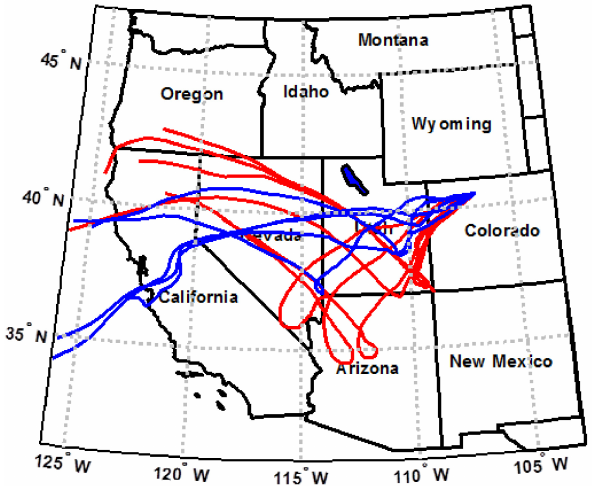
Fig. 5. Back trajectories for 11 March (blue) and 15 March